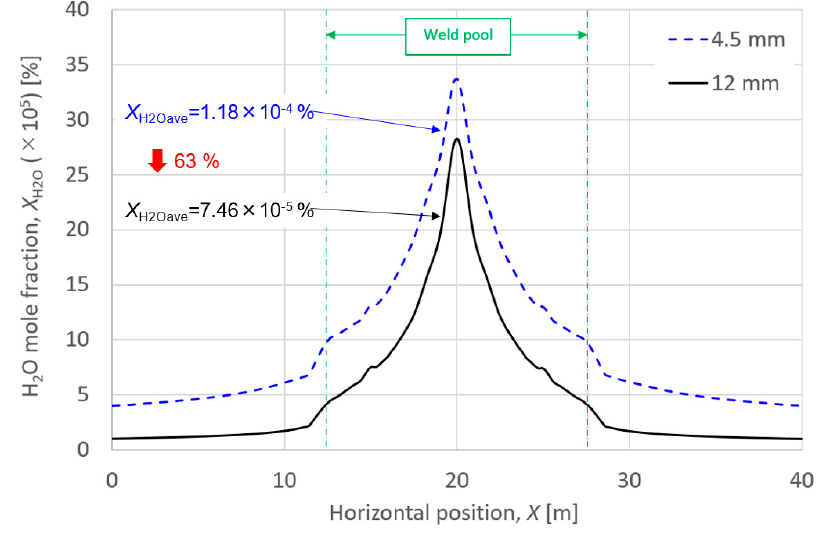
Figure 3. Horizontal distribution of the H 2 O mole fraction over base metal surface.